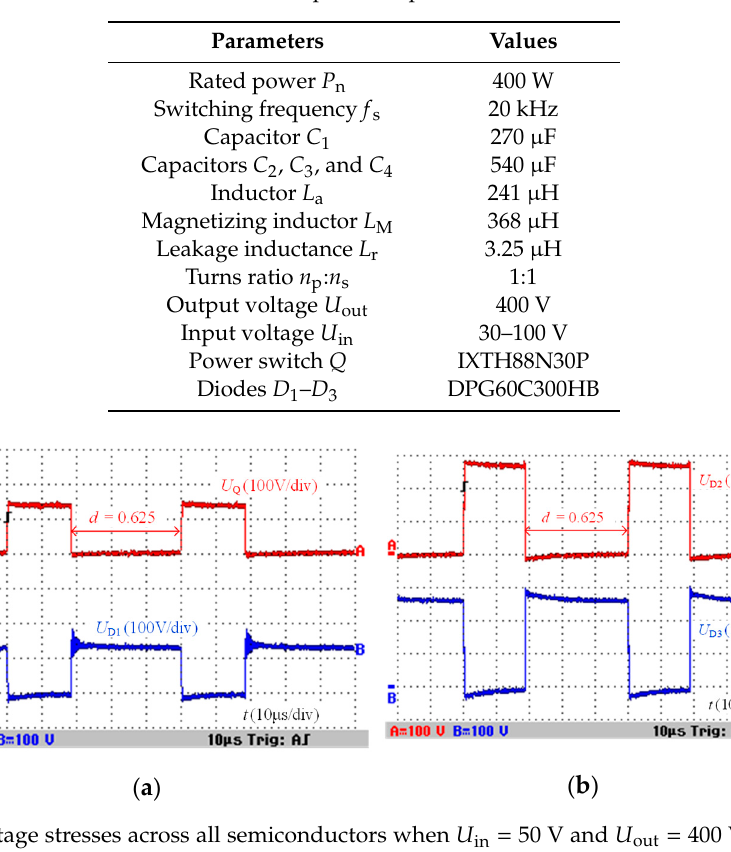
Figure 9. The currents flowing into both sides of the coupled inductor. Figure 10 shows that with the voltage control loop, the output voltage U out could be kept constant at 400 V, even when the input voltage U in varied from 30 V to 100 V continuously. This demonstrated that the proposed converter could operate well in a wide voltage gain range from 13.33 to 4. The efficiencies of the proposed converter with different input voltages and different powers were measured by a power analyzer (YOKOGAWA/WT3000), as shown in Figure 11. When the input voltage U in = 100 V and the load power P = 400 W, the proposed converter reached a maximum conversion efficiency of 95.12%. The minimum efficiency was 89.24% when the input voltage U in = 40 V and the load power P = 400 W. To sum up, with the same power, as the voltage gain increased (i.e., the input voltage decreased), the efficiency of the proposed converter decreased. Since the input current rose as the low-side voltage decreased, the copper loss and the switching losses of the converter rose. Therefore, the efficiency of the converter appeared to degrade at a high voltage gain.